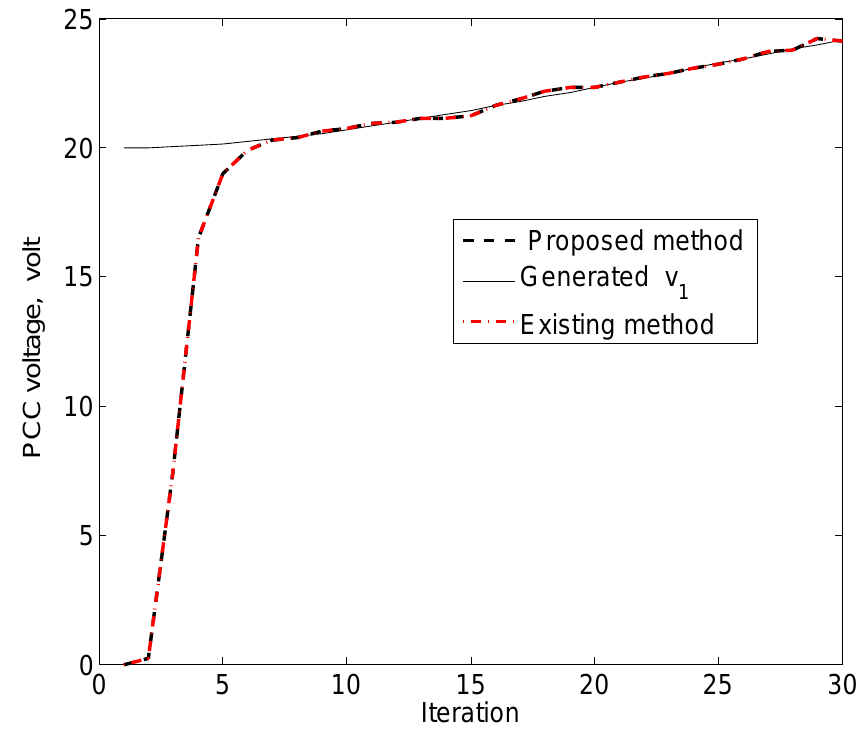
Figure 14. PCC voltage estimation for v